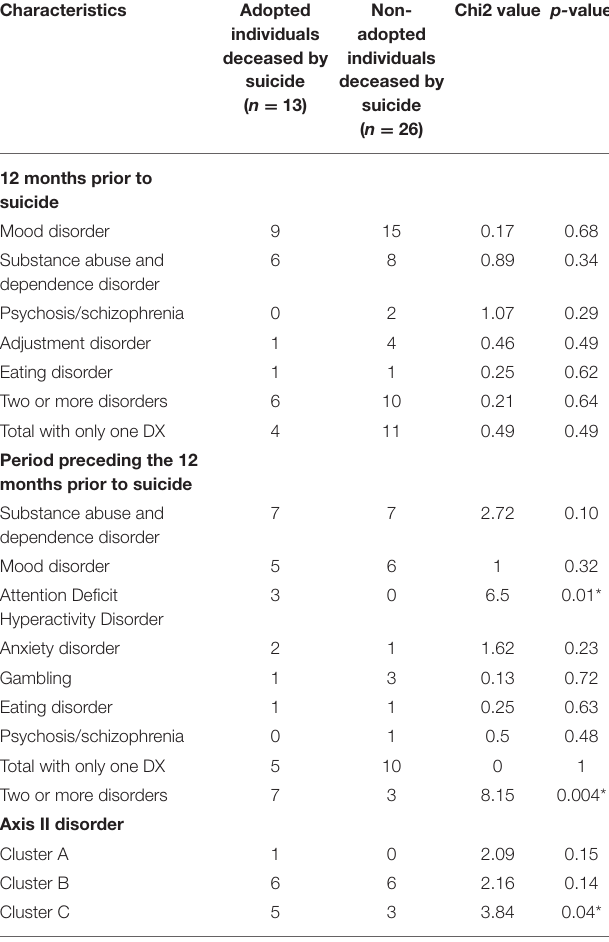
TABLE 1 | Comparison of an Axis I and II disorders in the 12 months prior to suicide, and the period preceding the 12 months prior to suicide between adopted and non-adopted individuals ( n =